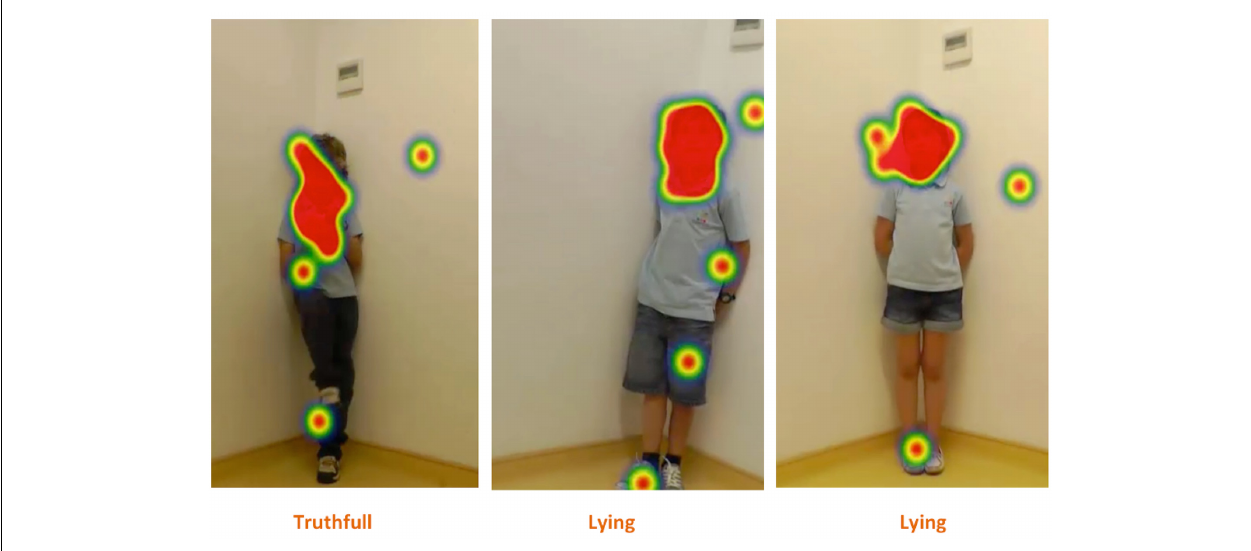
FIGURE 5 | Illustration of a heat map showing all the judges’ fixations in each of the conditions three conditions (Tc, Ly1, and